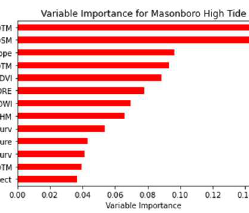
Figure 11. Feature Importance for Masonboro High Tide. St James, and Castle Bay for XGBM trained on Leave-One-Site-Out pooled data.